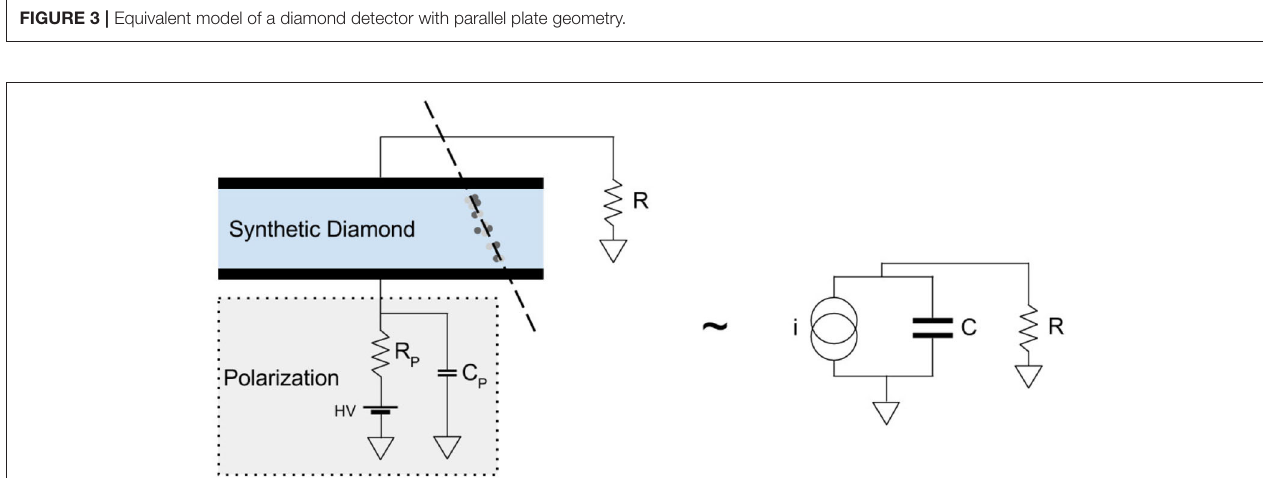
FIGURE 4 | The simplest way to read the current generated by a diamond detector is using a resistor.